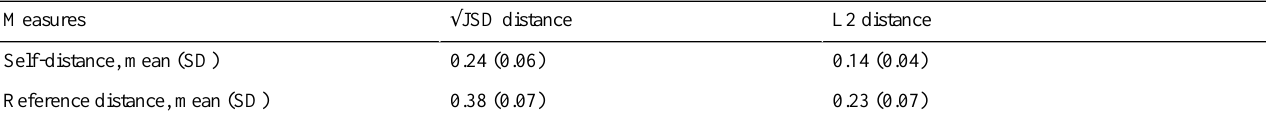
L2 distance √ JSD